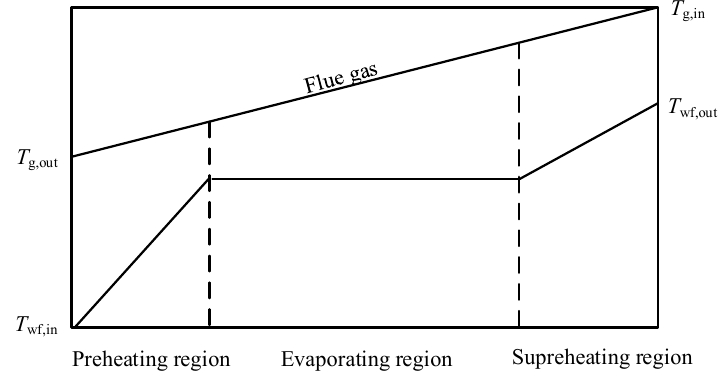
Figure 4. The temperature profile in HRSG.